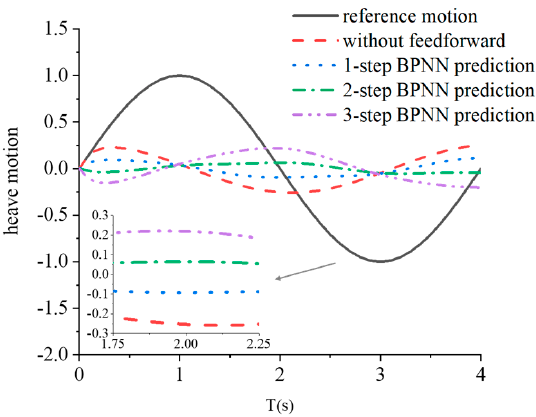
Figure 8. Controller response motions of a sinusoidal signal based on prediction feedforward control.